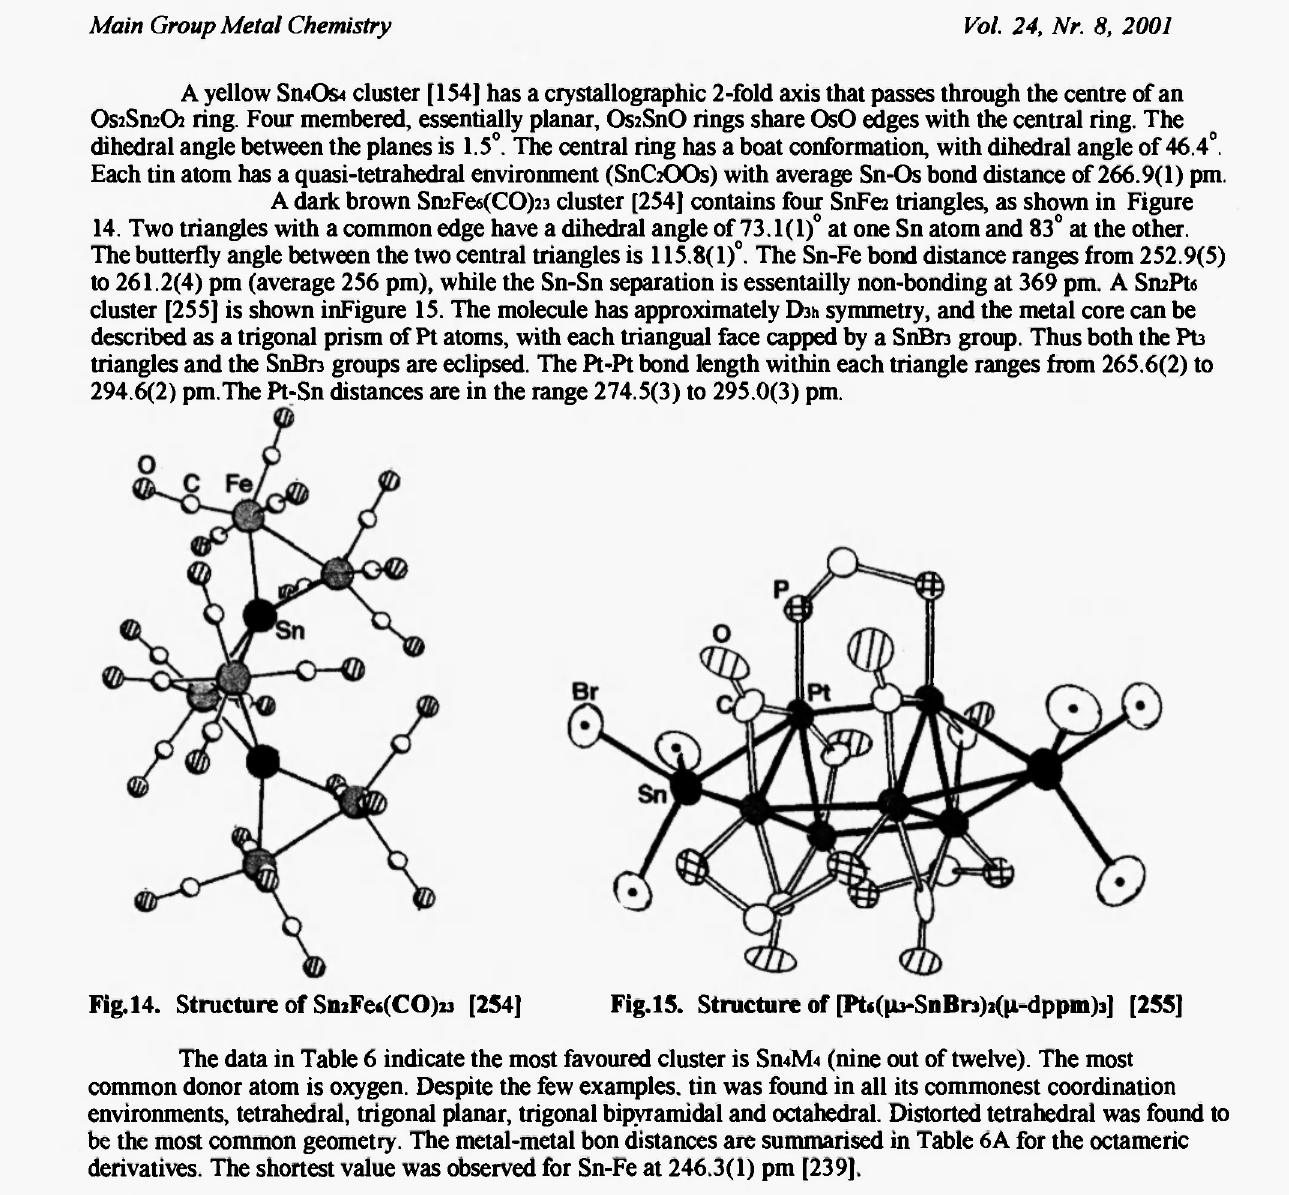
Fig. 14. Structure of Sn2Fe6(CO)u [254] Fig.15. Structure of [Ptt(|ii-SnBrj )2 ^-dppm)j]